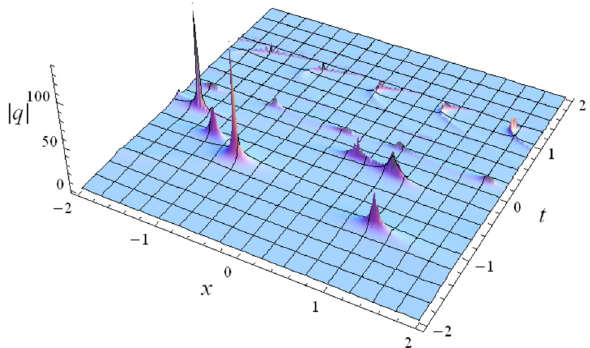
Figure 6. Space–time dynamical evolution of the solution determined by Equation (95) with κ 1 ( 0 ) = 0.5, κ 2 ( 0 ) = − 1, α = t − 1, β = 1, γ = t + 1 and δ ( t ) = i